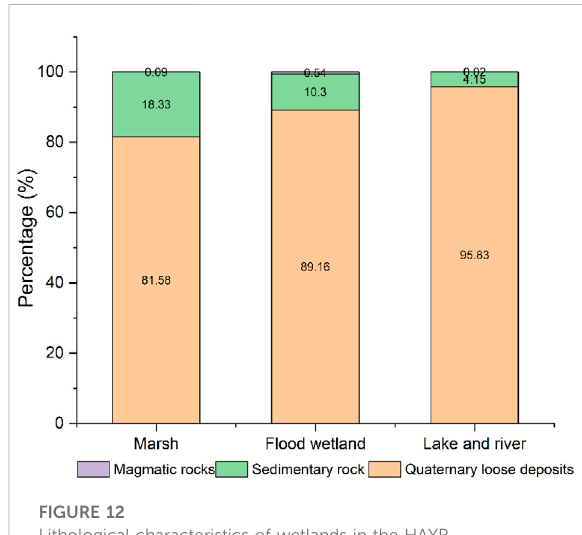
Lithological characteristics of wetlands in the HAYR.